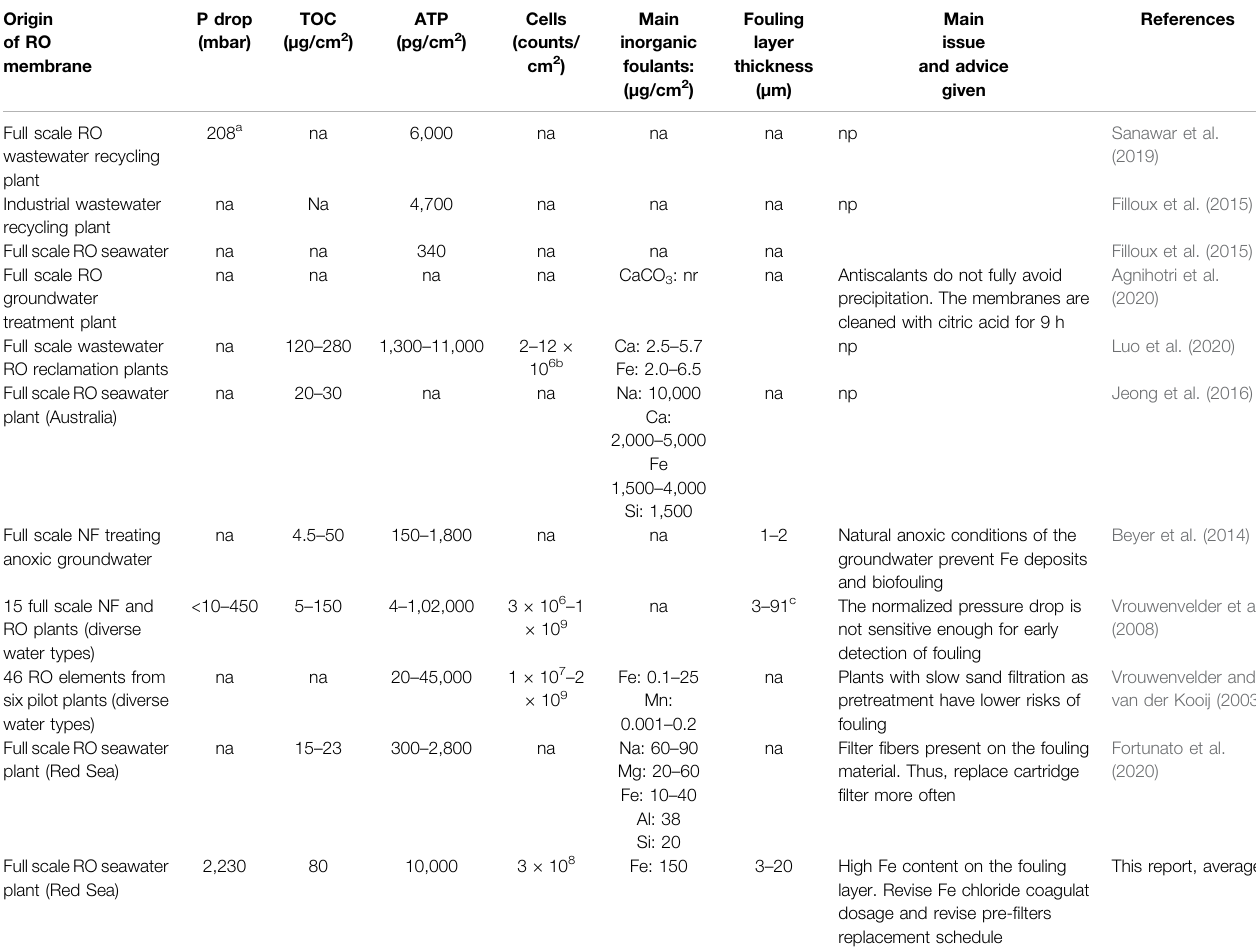
TABLE 3 | Indicators of organic fouling and biofouling from full-scale spiral wound RO